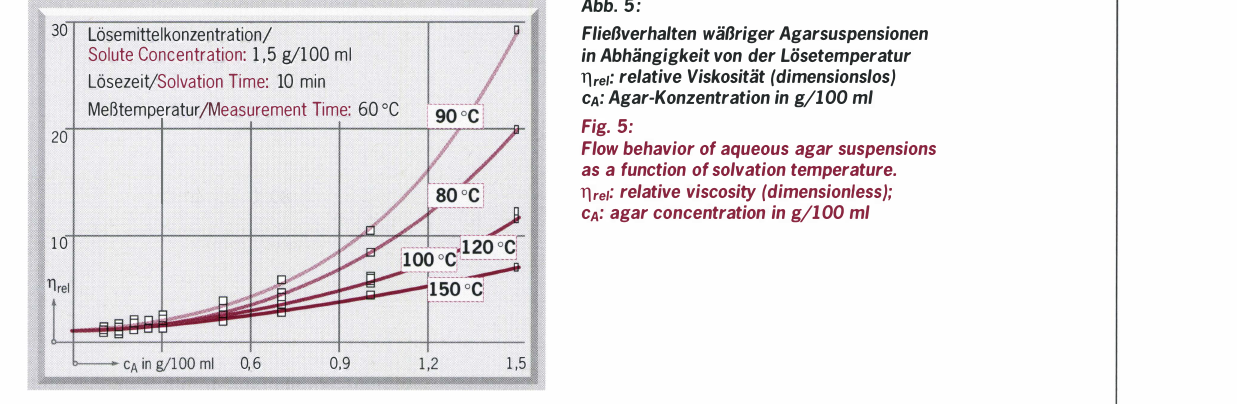
Fig. 6: Flow behavior of aqueous agar suspensions as a function of solvation